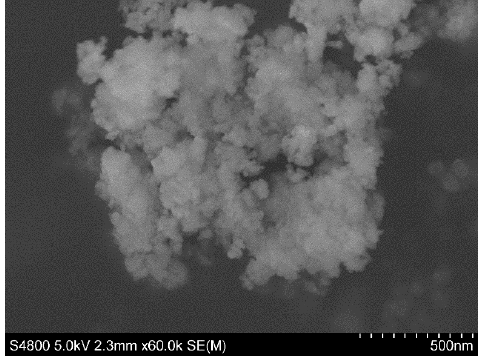
Figure 2. Scanning electron microscopy (SEM) micrographs of Fe-doped hydroxyapatite (FeHA) nanoparticles.